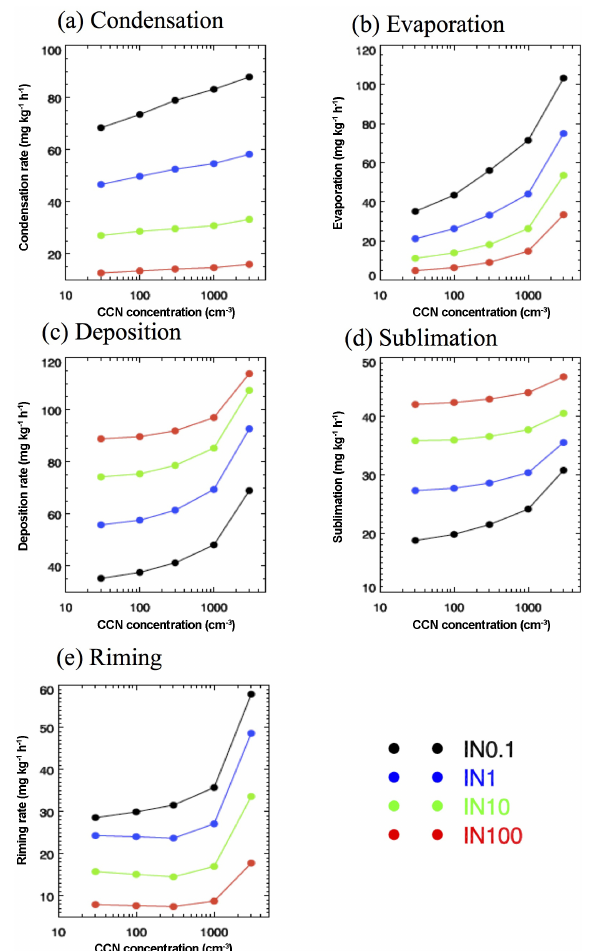
Figure 4. The microphysical process rates of (a) condensation, (b) evaporation, (c) deposition, (d) sublimation, and (e) riming for the CMOC. The model outputs for the process rates are every 6min, and the data shown in the plots were processed in the same way as Fig.